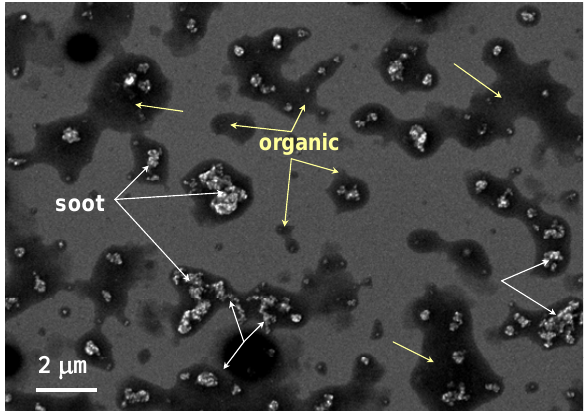
Figure 5. Secondary electron (SE) microscopy image of smoke particles generated during Fig. 5. Secondary electron (SE) microscopy image of smoke parti- the burn of ponderosa pine fuel. Typical particles are composed of soot cores coated with cles generated during the burn of ponderosa pine fuel. Typical par- oily organic material (labeled). The sample was collected for the aerodynamic diameter ticles are composed of soot cores coated with oily organic material size range between 0.32-0.5 μ m (labeled). The sample was collected for the aerodynamic diameter size range between 0.32–0.5µm.